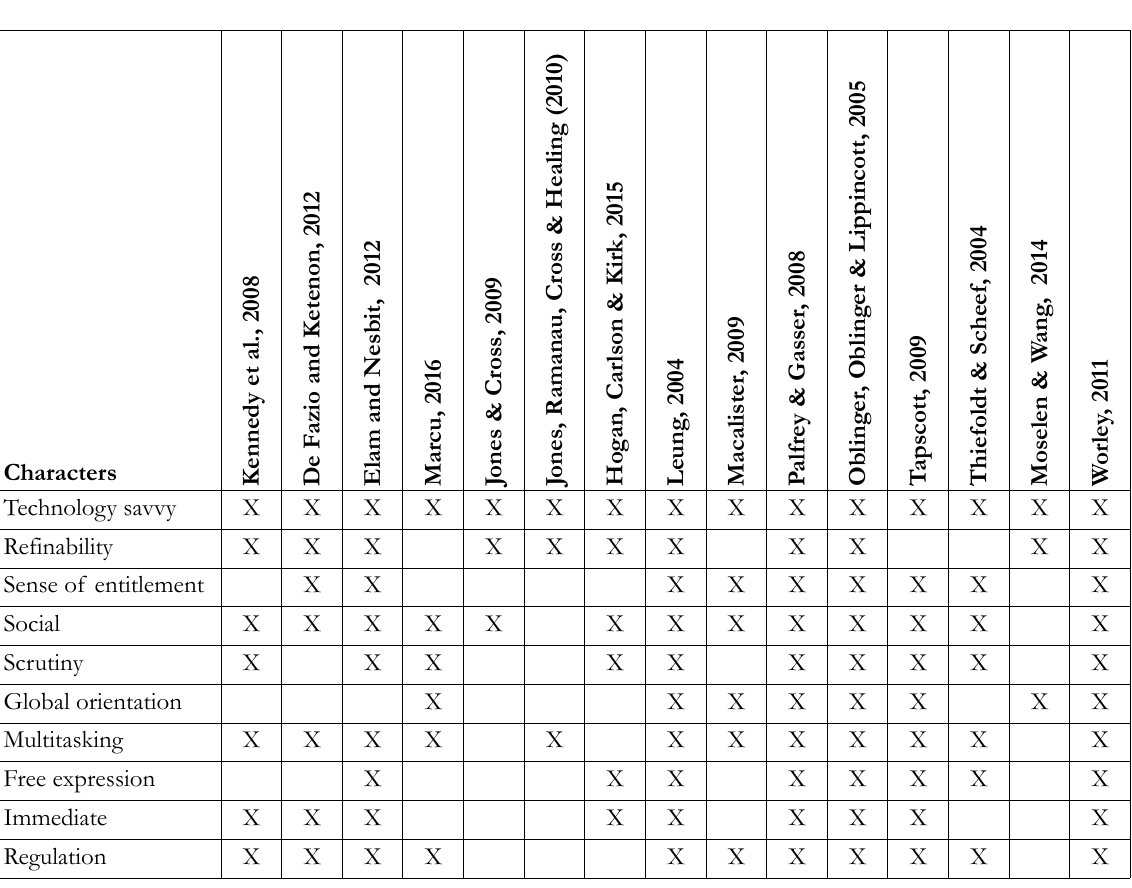
Table 1. Characteristics of the Net-Generation (Kim & Ammeter,